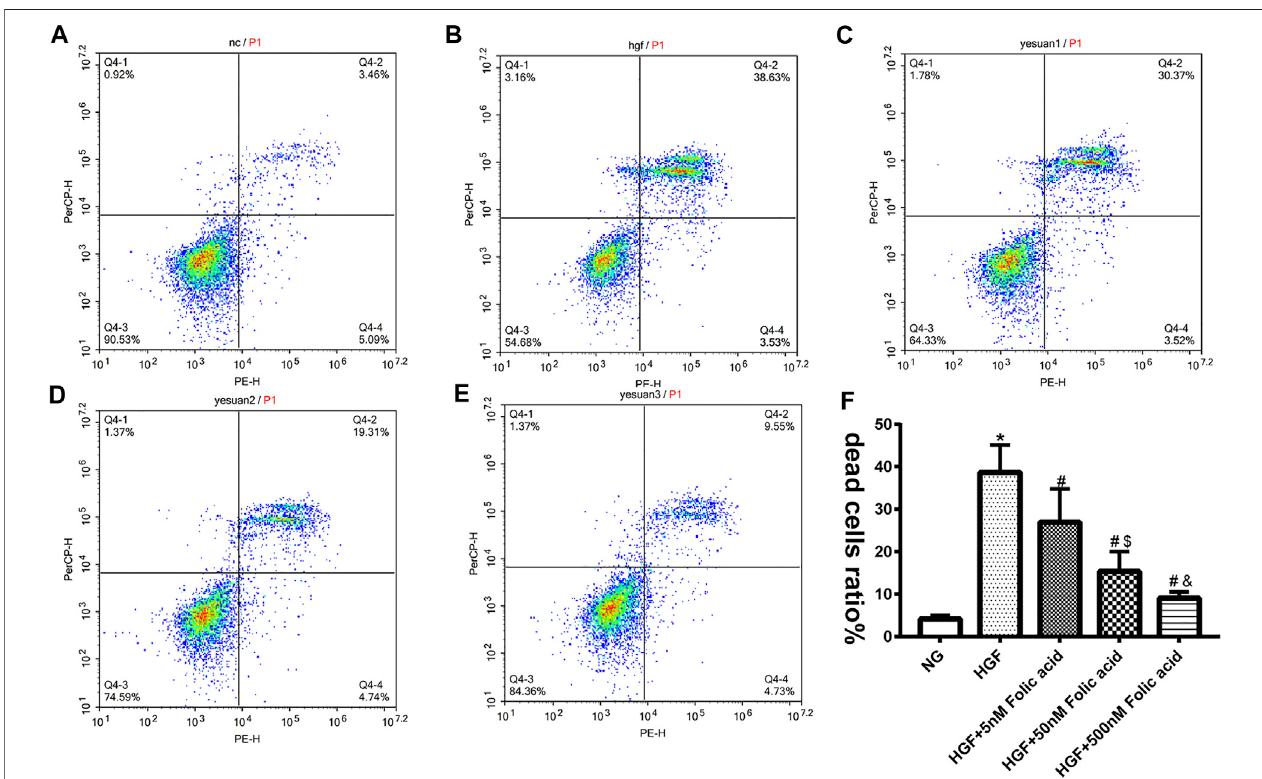
FIGURE 3 | Effect of folic acid on the ratio of dead cells. (A – E) Representive fl ow cytometry plots showing percentage of dead cells treated with NG, HGF, 5 – 500 nMfolicacidandHGF (F) PercentageofAnnexinVand7-AADpositivecells.* p < 0.05,compared withNG; # p < 0.05,compared withHGF; & p < 0.05,compared with HGF+50 nM folic